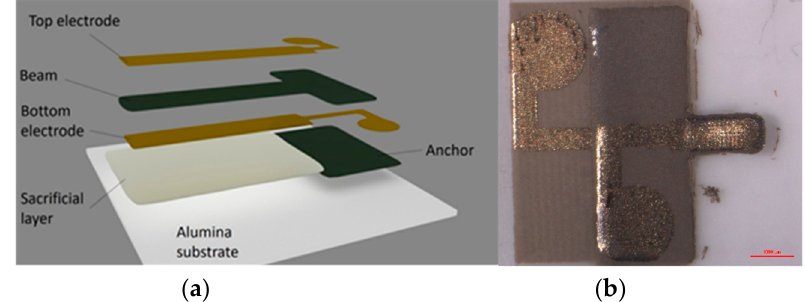
Figure 1. ( a ) Exploded view of the layer piling. ( b ) Photo of a 2x1x0.1 mm 3 microcantilever.